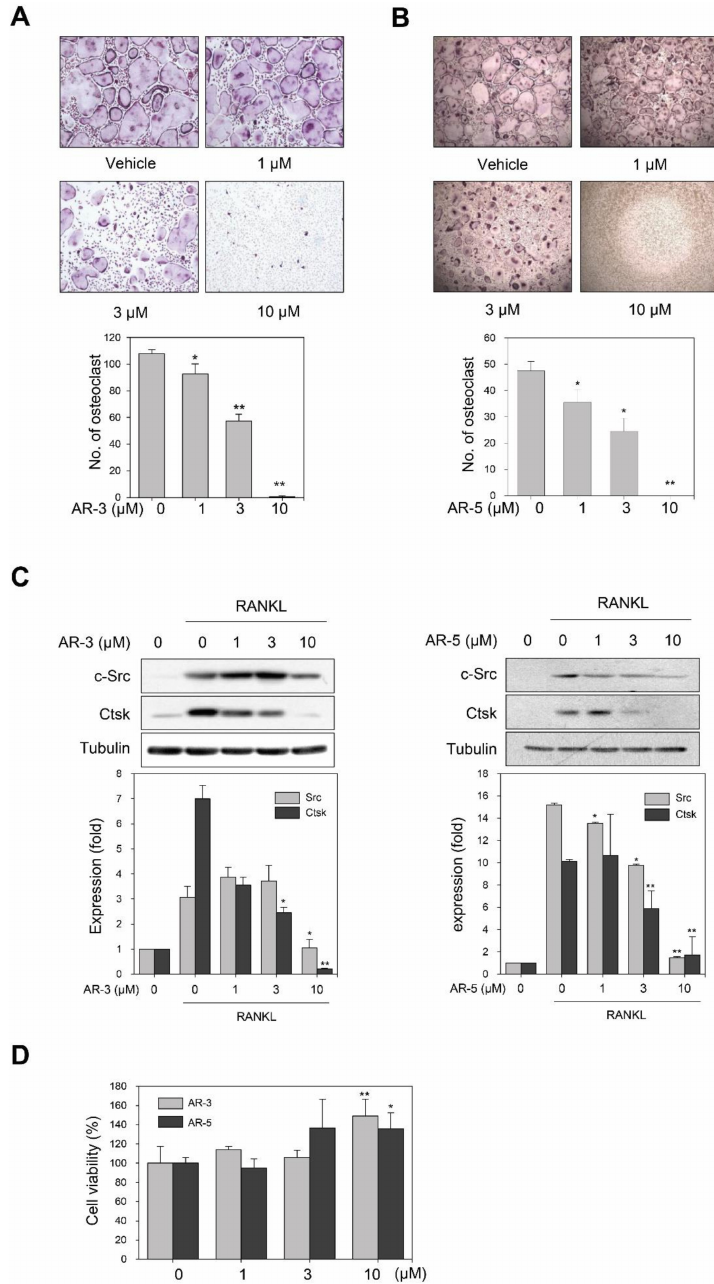
Figure 2. AR-3 and AR-5 suppress RANKL-induced osteoclastogenesis in BMMs. ( A , B ) BMMs were treated with the indicated concentrations of AR-3 ( A ) or AR-5 (B), and then stimulated with M-CSF and RANKL for seven days. The cells were stained for TRAP. The number of TRAP-positive osteoclasts ( > 5 nuclei) was determined following image capture. Data are presented as the mean ± SE (* p < 0.05 and ** p < 0.01, versus vehicle-treated control; n = 3). ( C ) BMMs were treated with the indicated concentrations of AR-3 (left panel) or AR-5 (right panel), and then stimulated with RANKL for four days. Total lysates were prepared and the expression levels of c-Src and CtsK were determined by western blotting. Graphs represent densitometry analyses normalized to tubulin (* p < 0.05 and ** p < 0.01, versus vehicle-treated control; n = 3). ( D ) BMMs were incubated with M-CSF in the presence of the indicated concentrations of AR-3 or AR-5 for four days. Cell viability was measured using the MTT assay. Data are presented as the mean ± SE (* p < 0.05 and ** p < 0.01, versus vehicle-treated control; n =